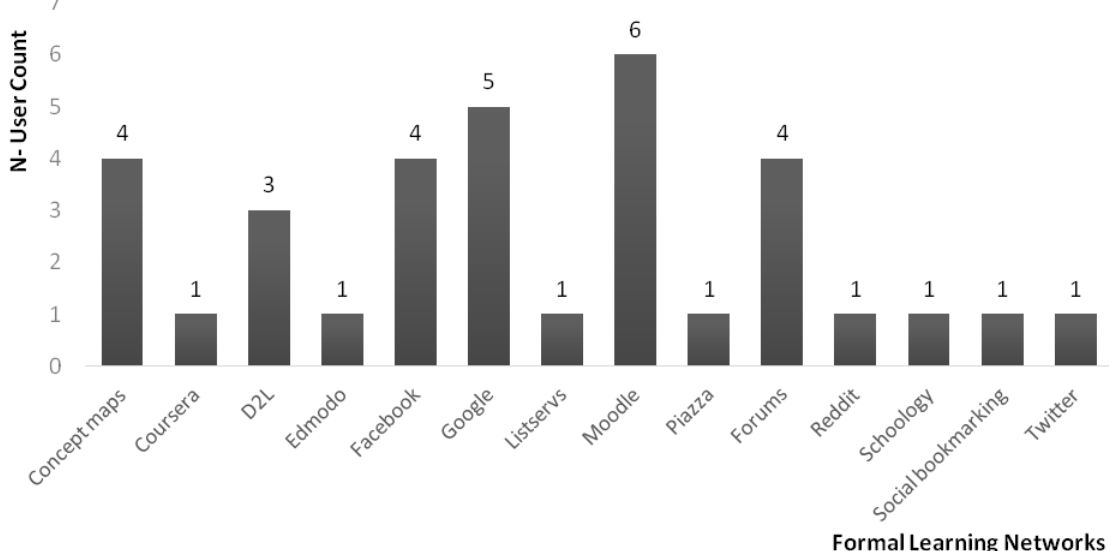
Figure 2 . Formal learning networks identified by